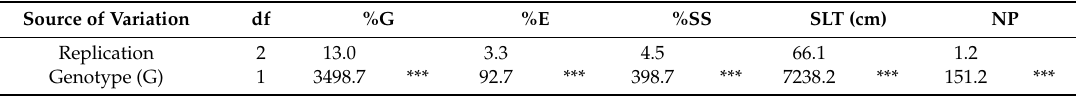
Table 3. Mean-square values and significance tests for germination percentage (%G), seedling